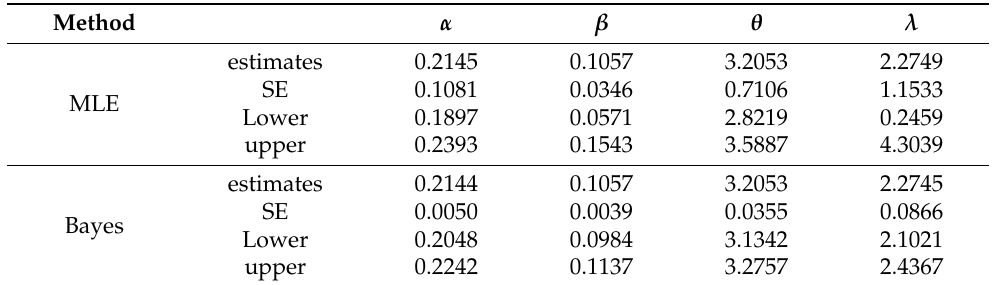
Table 21. LE and Bayesian estimation methods of the TLMW model parameters for single carbon fibers.